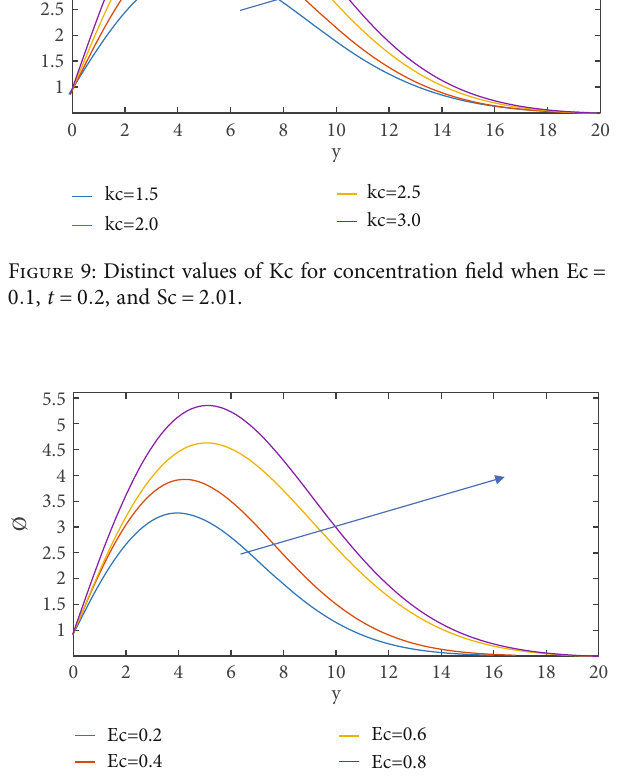
Figure 10: Distinct values of Ec for concentration fi eld when t = 0 : 2 , Kc = 1 , and Sc = 2 : 01